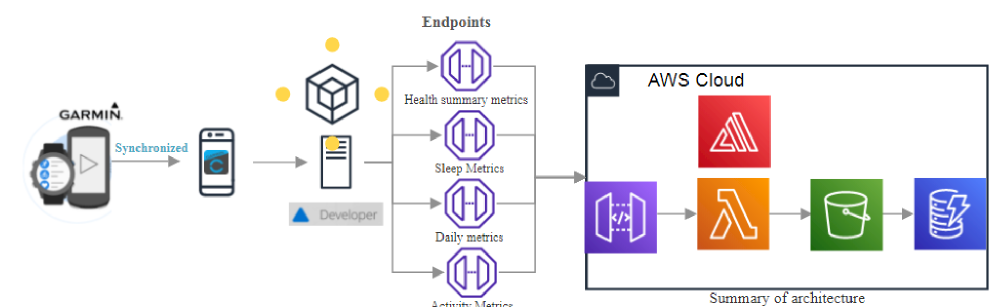
Figure 1. Health tracking